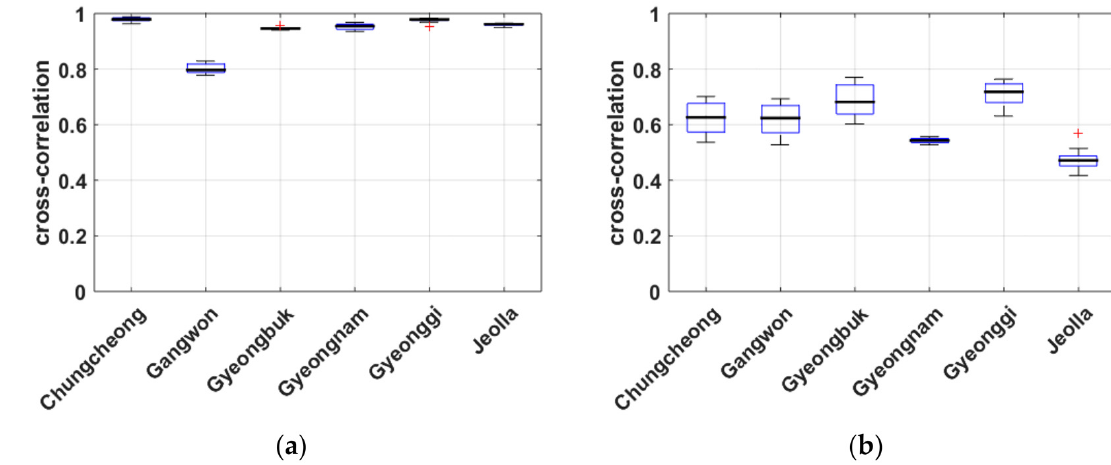
Figure 3. Comparison of cross-correlations of drought indices estimated using satellite remote sensing data and ground observation data. In each figure, the horizontal axis indicates the region and the vertical axis indicates cross-correlation. The cross-correlation between SPI-rs (or nEDDI-rs) and SPI-obs (or nEDDI-obs) calculated at each time scale is shown as a boxplot. ( a ) SPI. ( b )